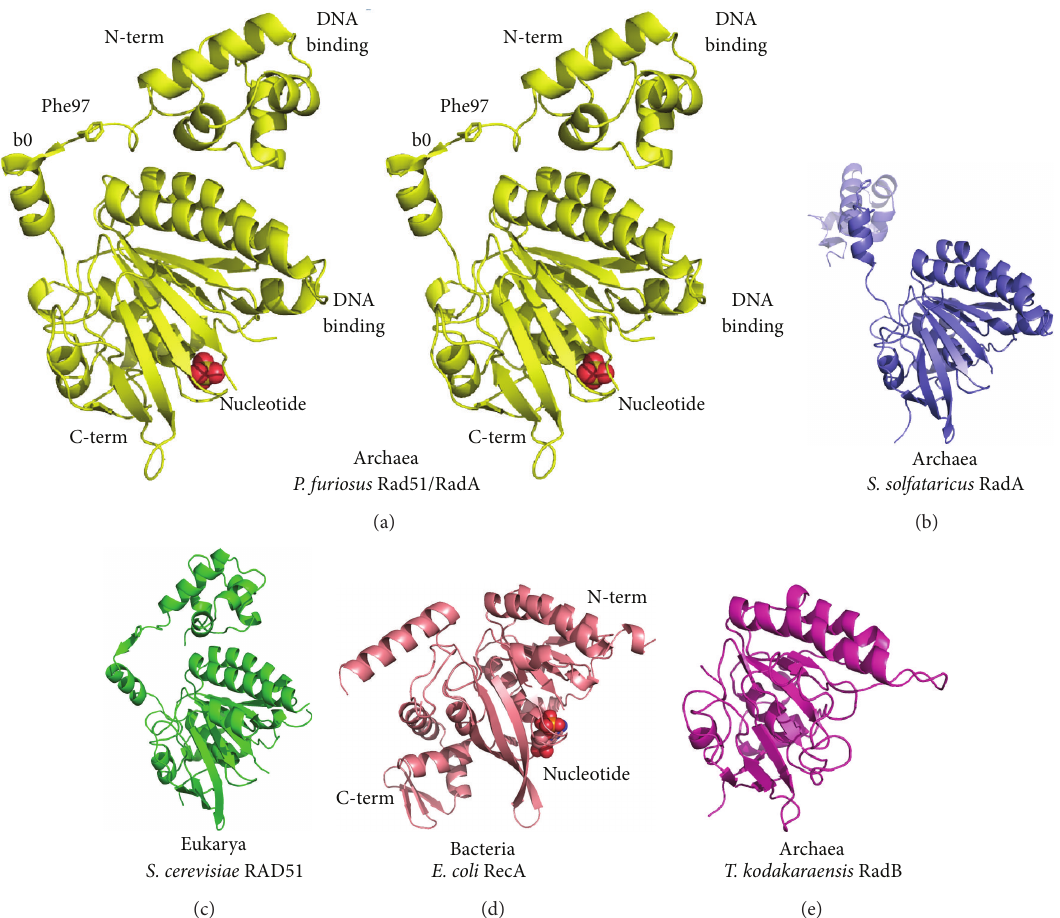
Figure 7: Structural comparisons of Rad51 family proteins. (a) Stereoview of archaeal P. furiosus Rad51 (PDB code 1PZN). While Rad51 generally forms larger homopolymeric assemblies, the prototypical fold of a single archaeal Rad51 or RadA protein consists of a small 4-helix bundle N-terminal DNA-binding domain, which is tethered to a larger C-terminal ATPase domain. The ATPase domain has several loops that are also implicated in binding DNA. The interdomain linker that tethers the two domains contains a polymerization motif (PM) that consists of a 𝛽 -strand 𝛽 0, which, upon contact with a neighboring subunit, extends the 𝛽 -sheet of the ATPase domain. Conserved Phe97 forms a ball and socket to stabilize this interaction. (b) The two domains of the archaeal S. solfataricus structure individually superpose well with the PfRad51 domains. However, this structure reveals the flexibility of the interdomain linker, where the N-terminal domain has swung outward (PDB code 2BKE). (c) The structure of S. cerevisiae RAD51 reveals structural conservation with the archaeal proteins (PDB code 1SZP). (d) The bacterial RecA protein shares the ATPase domain fold (PDB code 2REB). However, in this structure the ATPase is represented in the N-terminal domain, while in archaea and eukarya the ATPase is represented in the C-terminal domain. A small N-terminal arm extends from the bacterial ATPase and serves a similar function as the Rad51 PM. (e) The archaeal T. kodakaraensis RadB protein structure illuminates how extensions to the ATPase likely served as critical components of primordial recombination structures, where in the archaea and eukarya the N-terminal domain became an accessory domain, whereas in bacteria the C-terminus gave rise to an accessory domain (PDB code